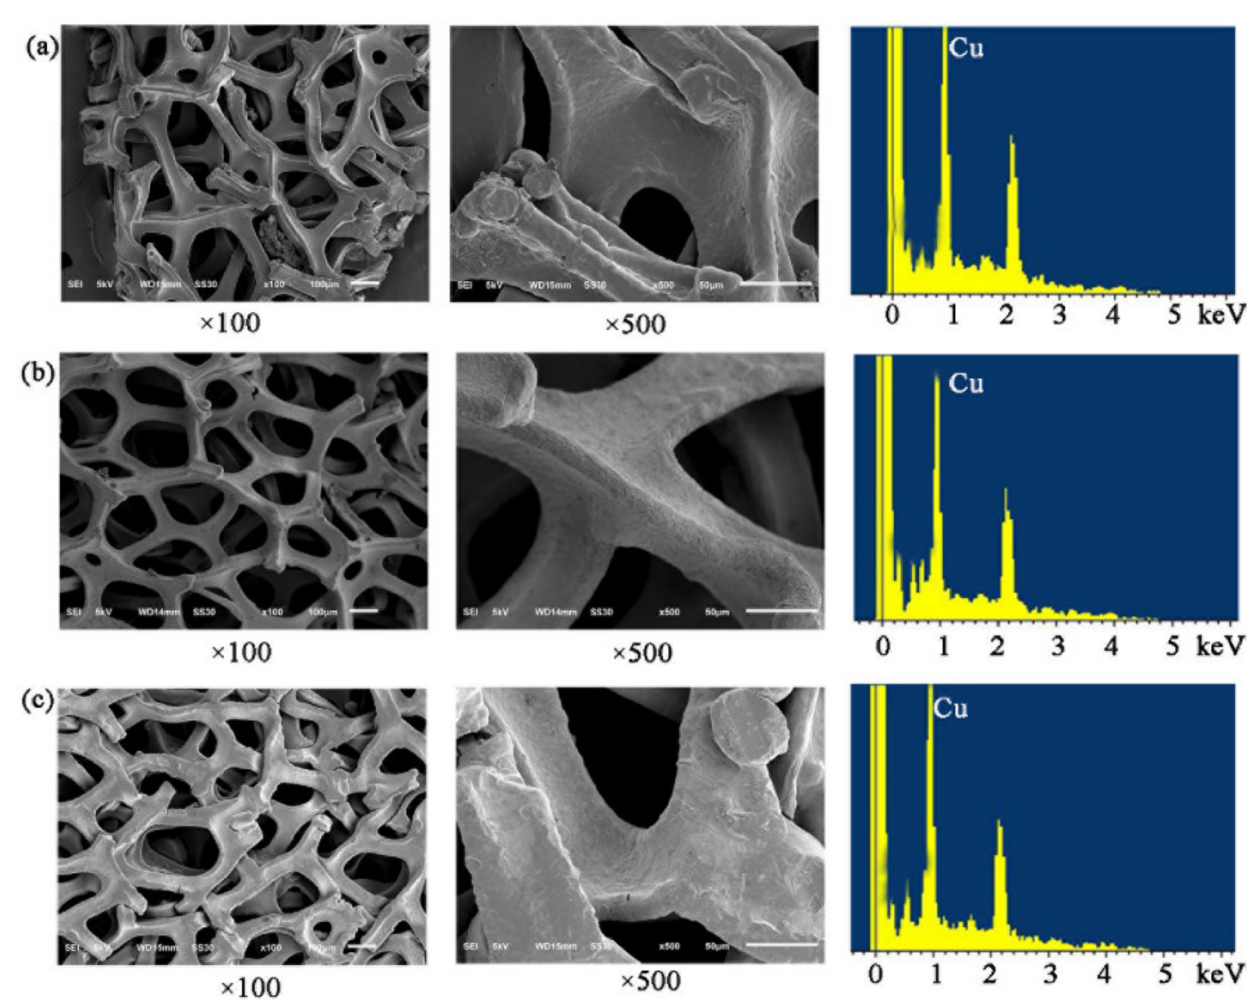
Figure 3. The SEM images of ( a ) copper foam (no reaction), ( b ) copper foam (after one reaction), and ( c ) copper foam (after five